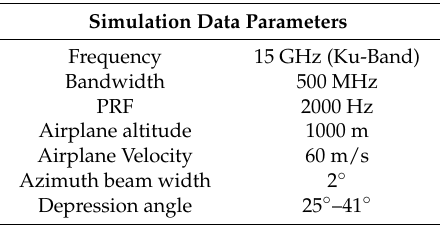
Figure 3. Antenna phase center (APC) trajectories. Table 1. System parameters used in the simulation data set.